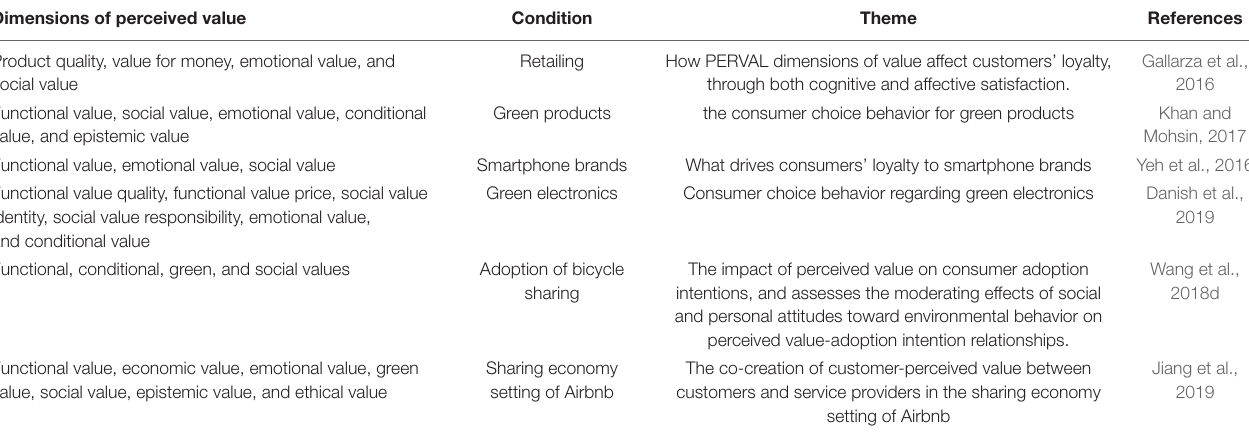
TABLE 1 | Selected studies on dimensions of perceived